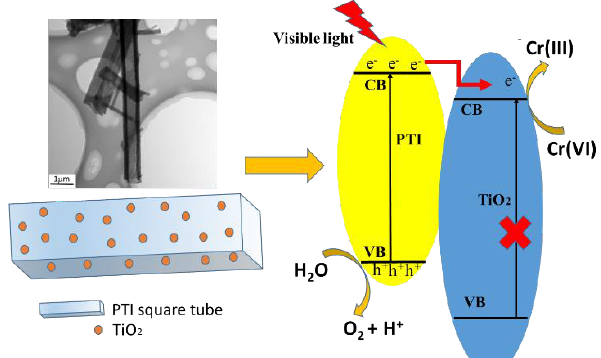
Figure 10. Schematic diagram of possible mechanisms in the PTI square nanotube/TiO 2 heterojunction.